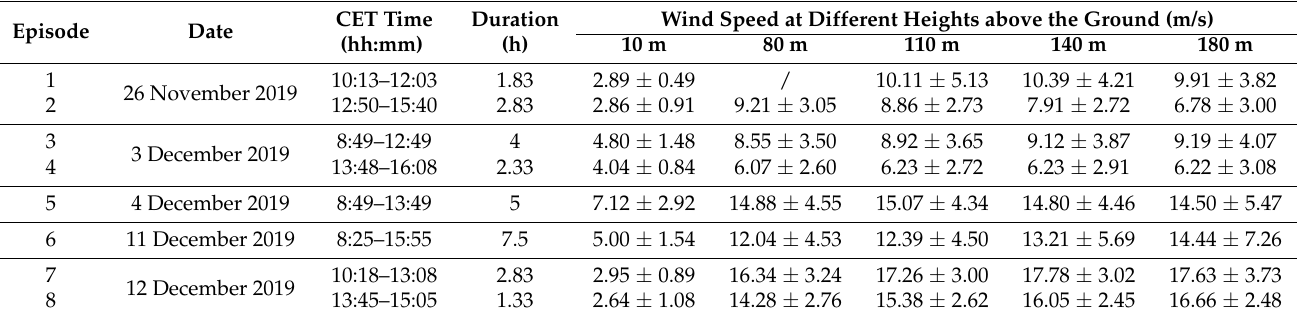
Table 2. Selected wind episodes at Ajdovšˇcina during November 2019 and December 2019 and their characteristics. Mean wind speed and standard deviation values of selected wind episodes, calculated from 10 to min averaged DWL wind speed data at four different heights AGL, are given along with the wind speed data at 10m AGL, calculated from 15 to min averaged wind speed data provided by DARS anemometer measurements.